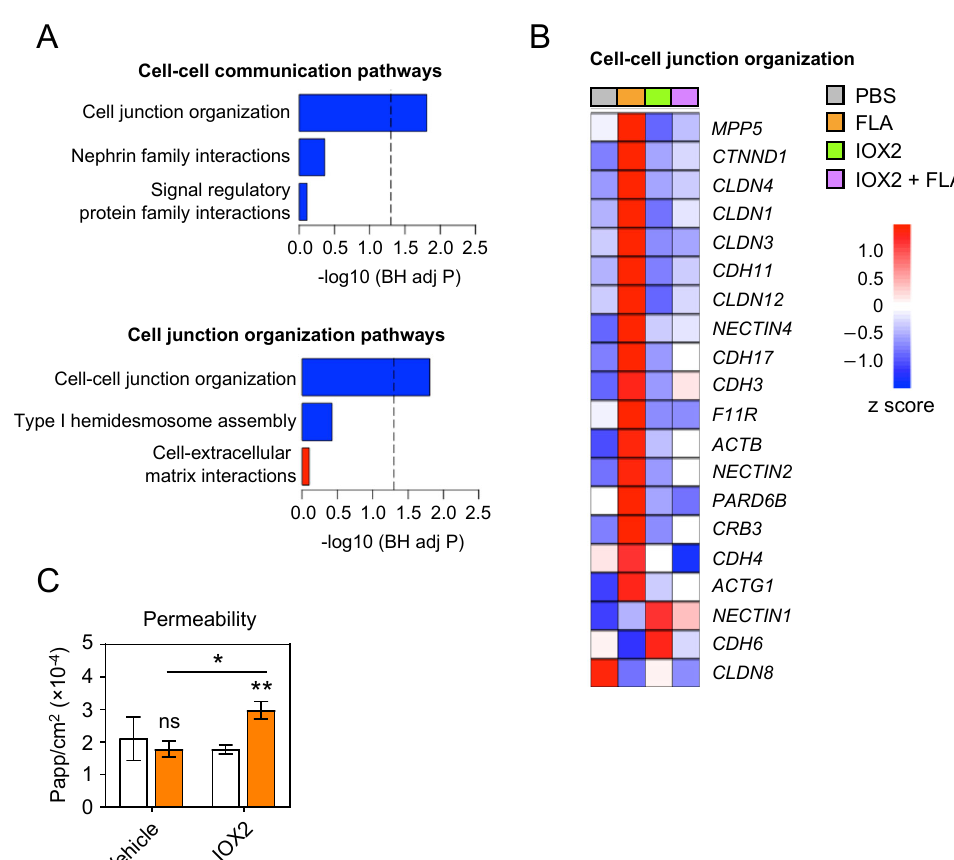
Figure 4. IOX2 inhibits expression of genes mediating cell–cell junction organization and compromises membrane permeability. ( A ) Cell–cell communication pathway analysis (R-HAS-1500931 in https://reactome.org, accessed on 8 September 2021) from genome-wide transcriptomic differences in HBE cells activated with flagellin for 24 h in the presence of IOX2 (added 1 h prior to stimulation) relative to that in the presence of vehicle. Data display child pathways enriched for upregulated (red) or downregulated genes (blue). ( B ) Heat map of changes in the expression of the cell–cell junction organization pathway genes in the indicated conditions. Red denotes high expression; blue indicates low expression. ( C ) Membrane integrity in HBE cells stimulated with flagellin or PBS (control) for 24 h with or without pre-incubation (1 h) with 50 µ M IOX2, as measured by diffusion of FITC–dextran beads from the apical to the basolateral compartment. Data in ( A , B ) comprise 3 biological donors with 1–2 replicates from 2 independent experiments ( n = 5). Data in ( C ) are displayed as mean ± SEM of 3–4 replicates representative of two experiments with similar results. p values were calculated using Student’s t test. * p < 0.05; ** p < 0.01; ns, not